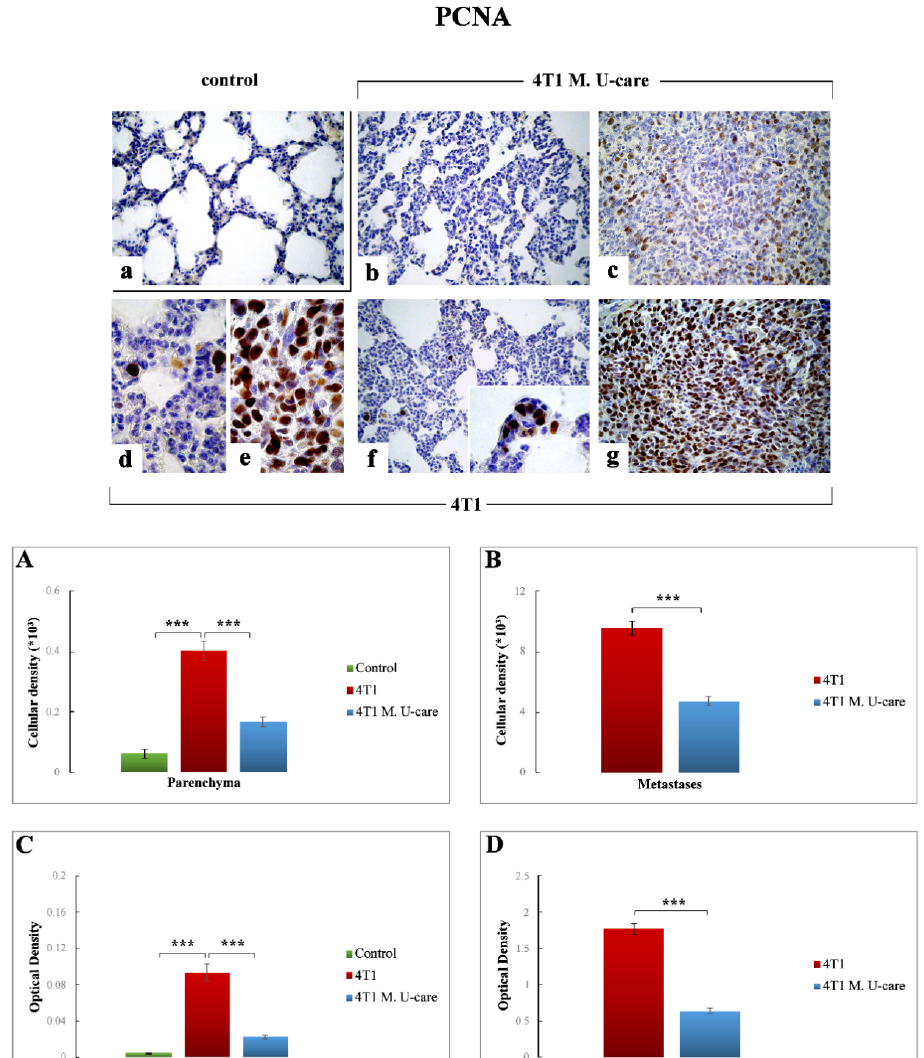
Figure 7. DAB-immunostaining reaction for PCNA in healthy control ( a ) 4T1 M. U-care ( b , c ), and 4T1 ( d – g ) mice. Light microscopy magnification: 40× ( a – c , f , g ); 100× ( d , e , insert in panel ( f )). Panels A and ( d – g ) mice. Light microscopy magnification: 40 × ( a – c , f , g ); 100 × ( d , e , insert in panel ( f )). Panels ( A ) B : Histograms showing immunopositive cell density. Panels C and D : histograms exhibiting and ( B ): Histograms showing immunopositive cell density. Panels ( C ) and ( D ): histograms exhibiting immunoreactive OD. p values calculated by Unpaired Student’s t -test: (***) < 0.001. immunoreactive OD. p values calculated by Unpaired Student’s t -test: (***) <